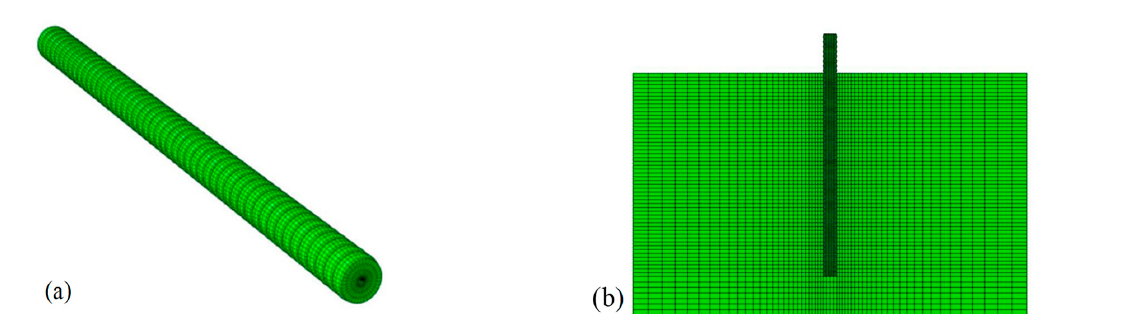
9 of 18 Figure 7. Axisymmetric model of GFRP anchorage concrete bottom plate. 4.2.2. Determination of Contact Relations and Boundary Conditions This section describes cohesive-element contact relations and interface friction based on the interface selection between the bolt and concrete block. When setting interface fric- tion parameters, the default penalty function contact was adopted, where the tangential friction coefficient was taken as 0.3. The cohesive element utilized a tractor-separation cri- terion, which specifies the stiffness coefficient. The damage criterion adopted the initial maximum nominal stress, and the damage evolution used the BK energy criterion and the linear softening method. Given that the stiffness of the GFRP bolt is greater than that of